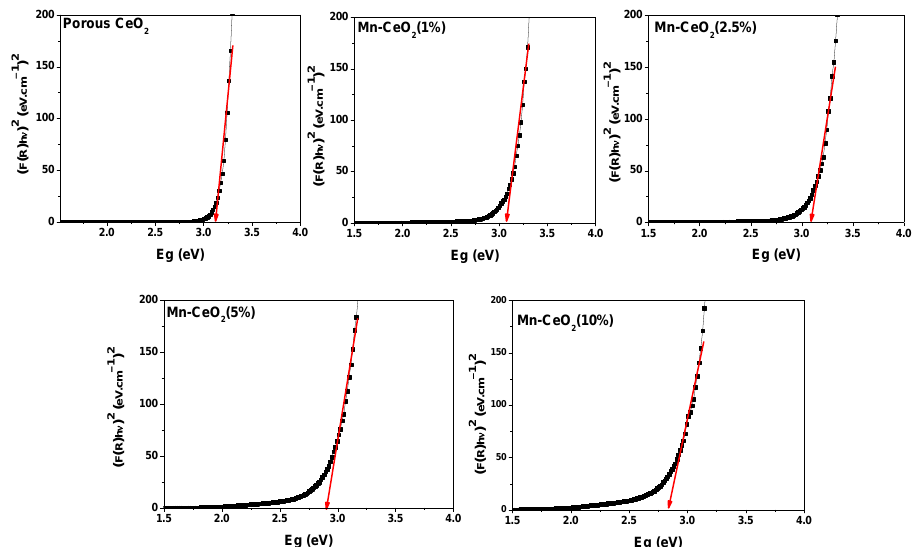
Figure 3. The bandgap calculation of Mn-doped porous ceria samples based on Kubelka–Munk function by using Tauc’s relation.